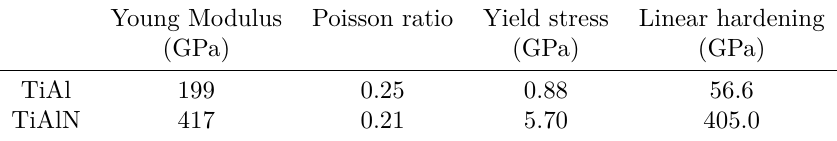
Table 2. Elastoplastic parameters of the metal TiAl and the nitride TiAlN.